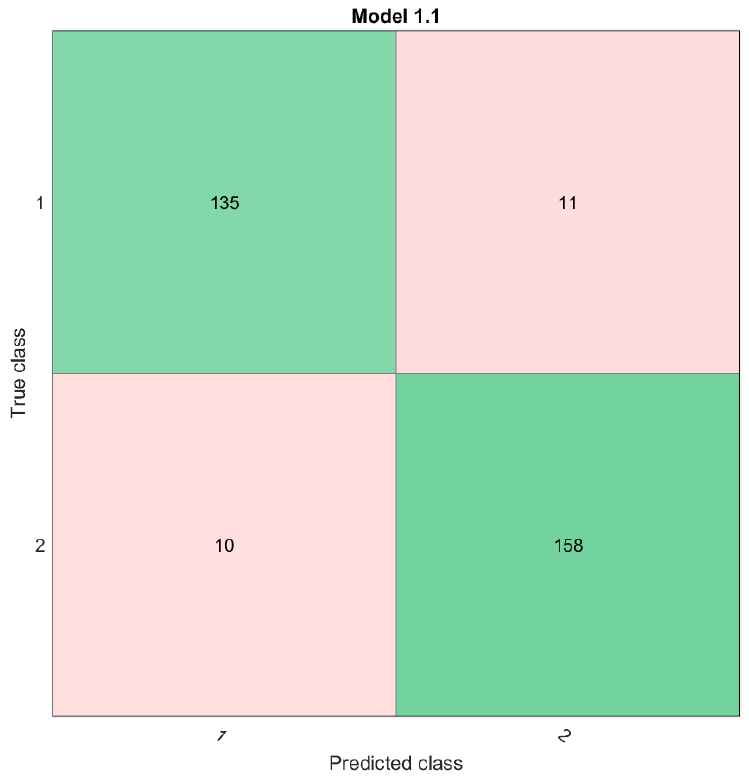
Figure 9. Confusion matrix after model training (2nd group of data; green—correct classification, red—misclassification).